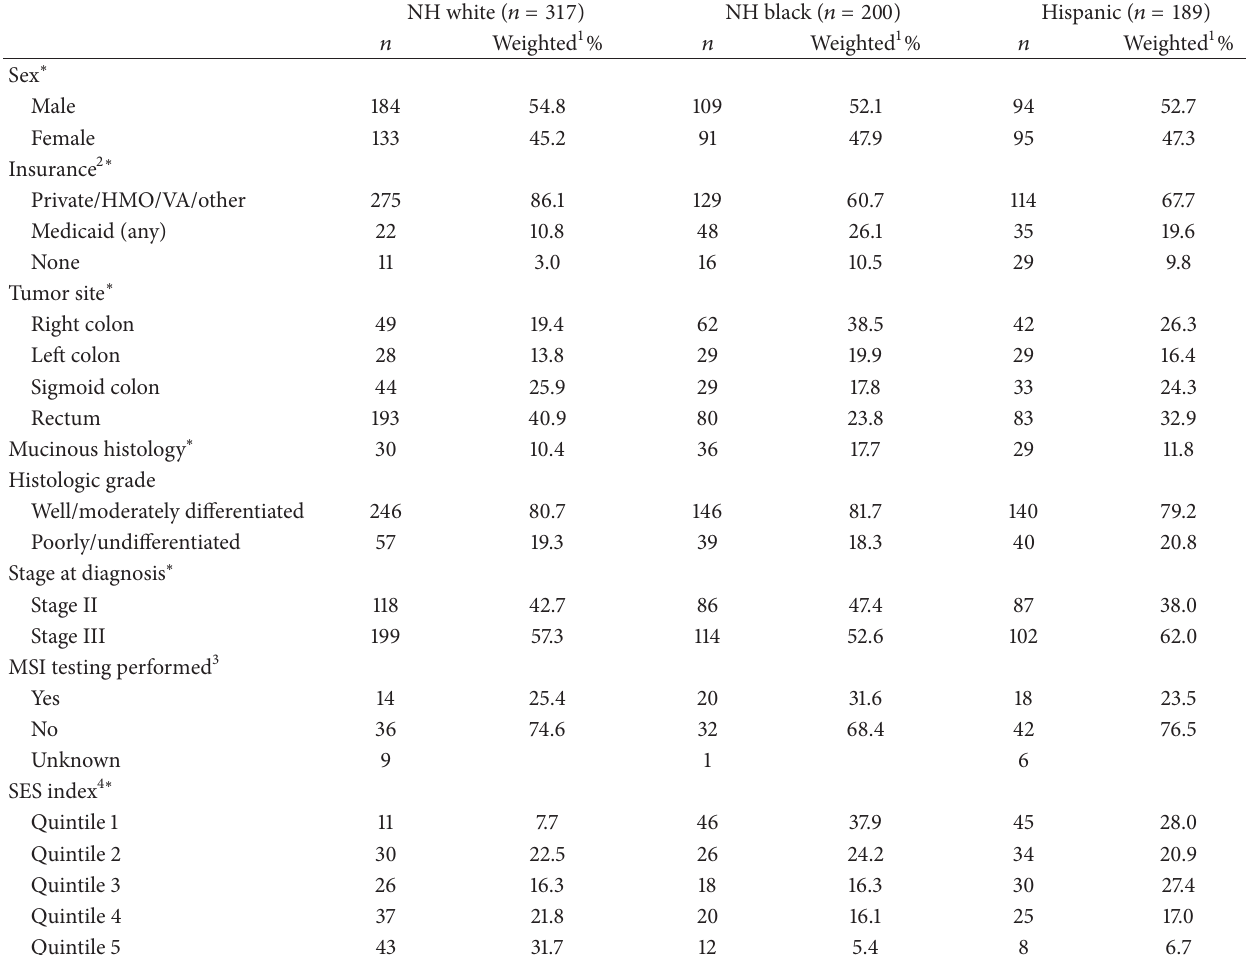
Table 2: Characteristics of 706 younger (age < 50 years) patients diagnosed with stages II and III colorectal cancer, 1990–2010, by